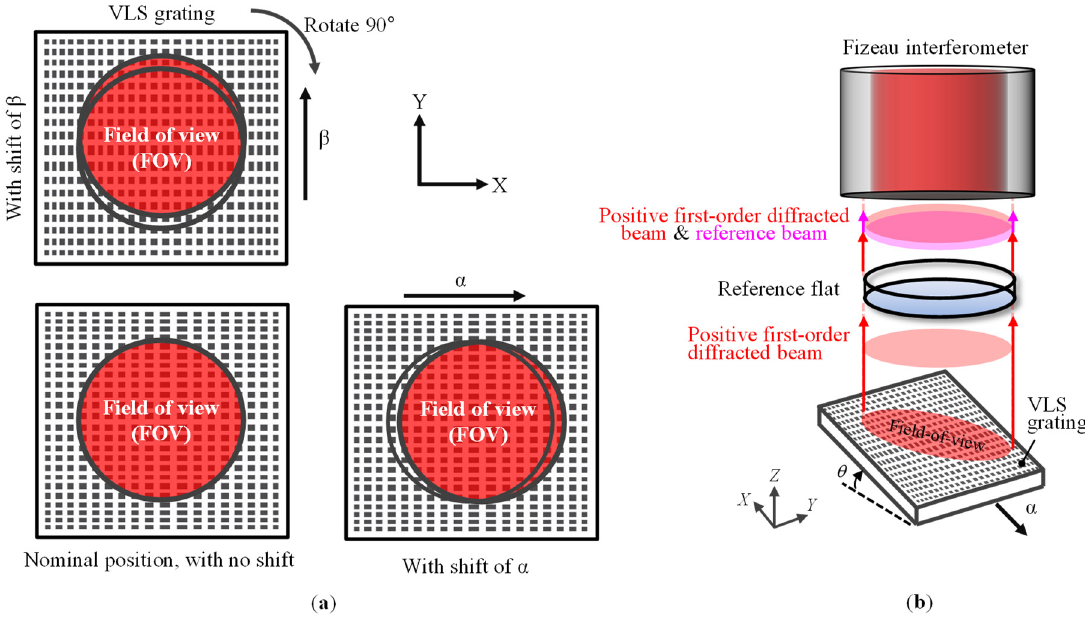
Figure 2. A new method integrating an interferometric pseudo-lateral-shearing method: ( a ) A schematic of the measurement procedure for calibration of the VLS parameters of the large-scale VLS grating; ( b ) A schematic showing the concept of the proposed method based on pseudo-lateral-shearing (In each of the three measurements, the interferometer is fixed with respect to the VLS grating).